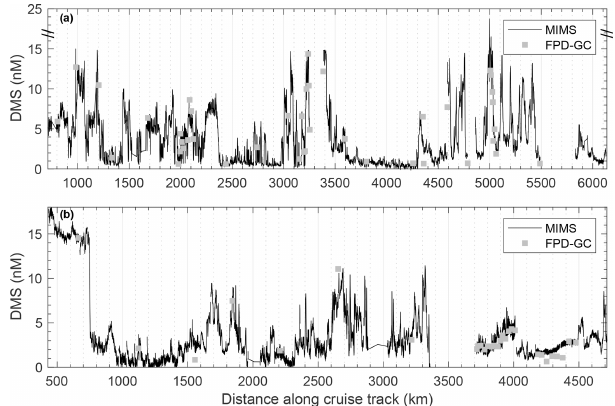
Figure 3. DMS concentrations during the O16 cruise in July 2016 (a) and the O17 cruise in August 2017 (b) , as measured by membrane inlet mass spectrometry (MIMS, continuous black line) and a purge-and-trap sampling system connected to a gas chro- matograph equipped with a flame photometric detector (grey sym- bols). Mean absolute error was 0.93nM and root-mean-square error was 1.4nM for all paired measurements between the two instru- ments. A linear regression of the two data sets yields a coefficient of determination of r 2 = 0 .